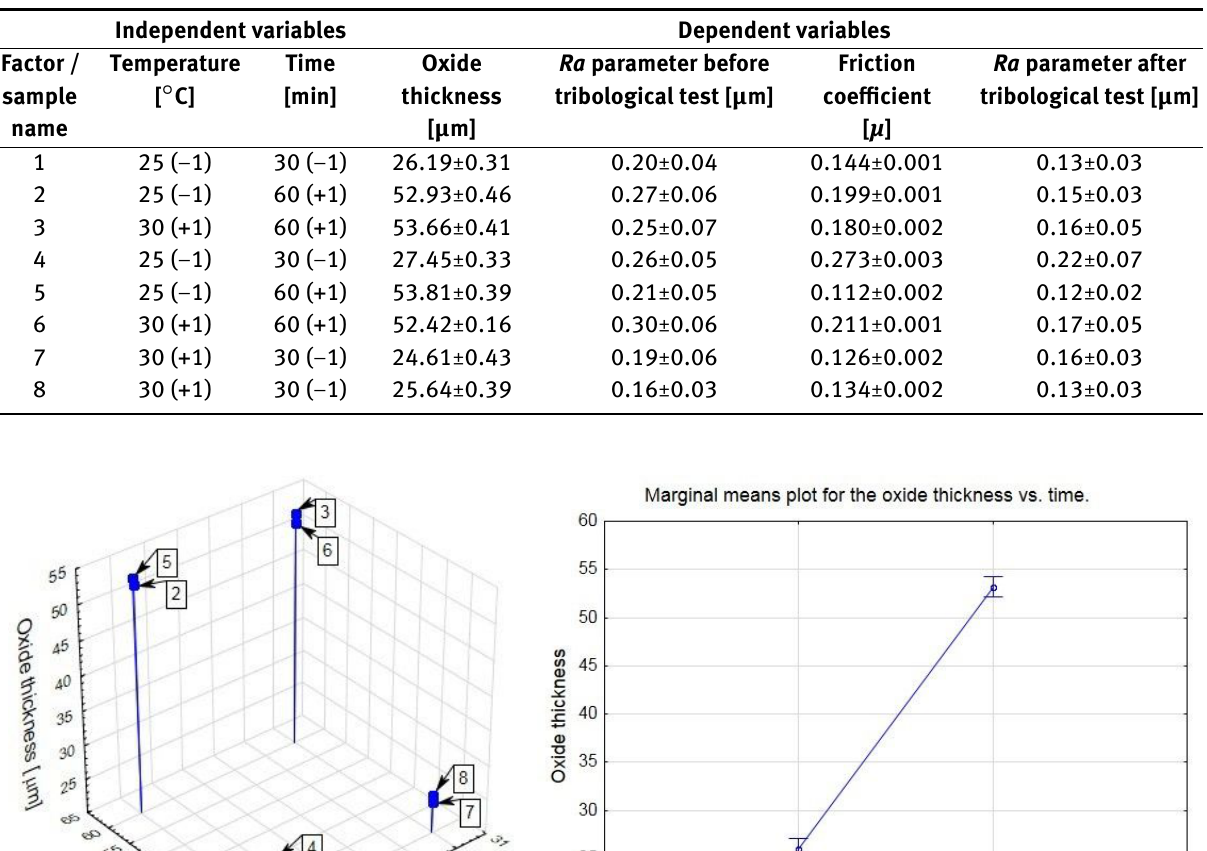
Table 2: Factor settings for 2 k factorial design